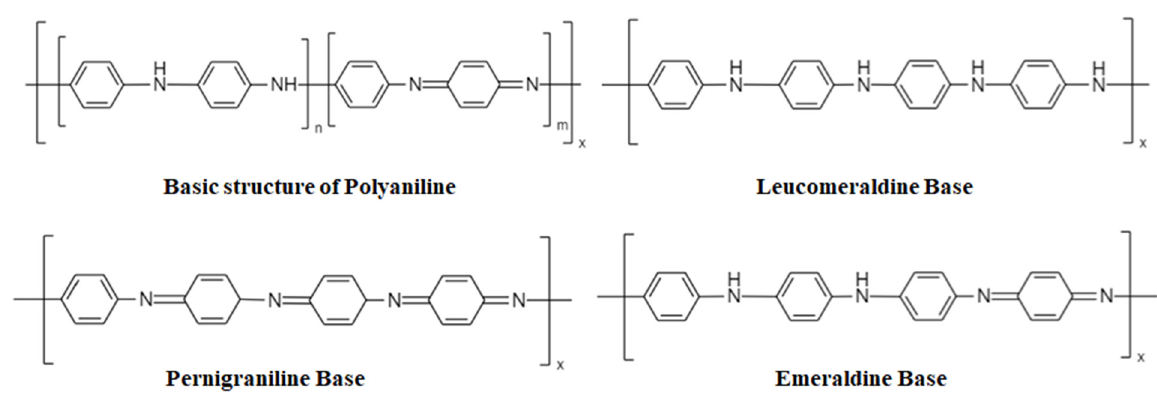
Figure 3. Different configurations of PANI structures.